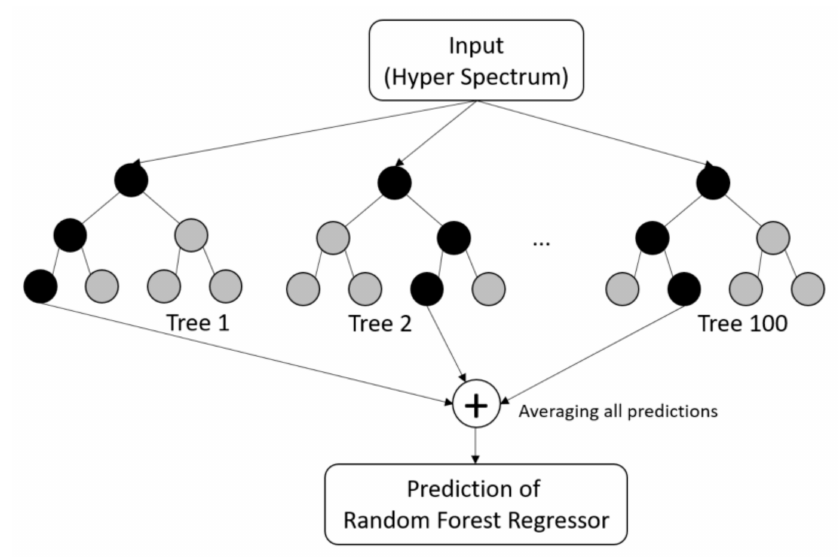
Figure 5. Structure of random forest